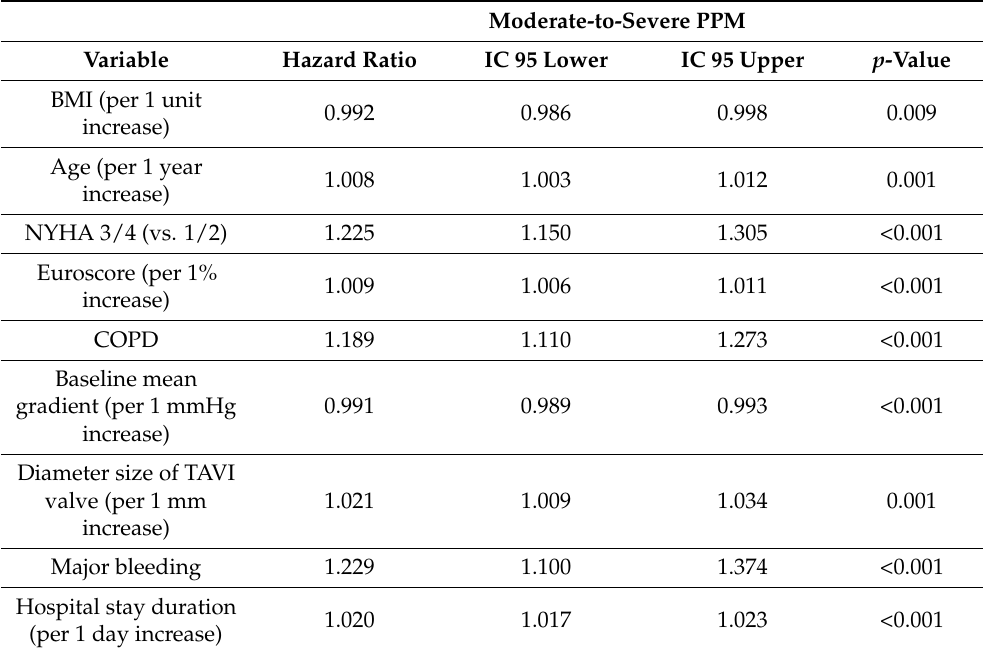
Table 5. Multivariate adjustment of predictors of all-cause mortality in PPM cohort.